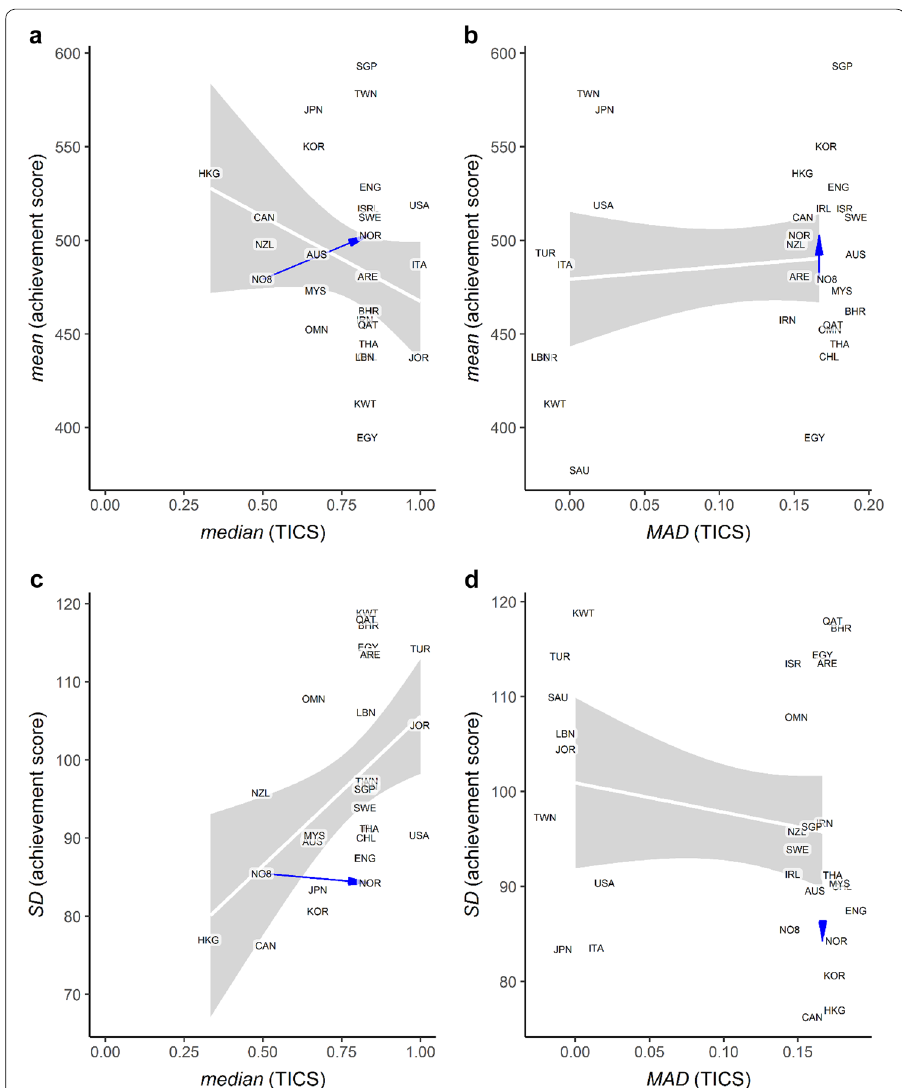
Fig. 7 a – d Scatterplots of between-country relationships in chemistry between central tendency (mean achievement and median TICS) and spread (standard deviation of achievement and median absolute deviation of TICS). The white line is the best simple linear fit line, and the gray band is its 95% confidence interval (bootstrapped from 10,000 draws). As there was little between-country variation in median absolute deviation (MAD) of TICS, the x -axis values in b and d were slightly jittered to increase visibility of points. The blue arrow indicates the shift from Norway grade 8 to grade